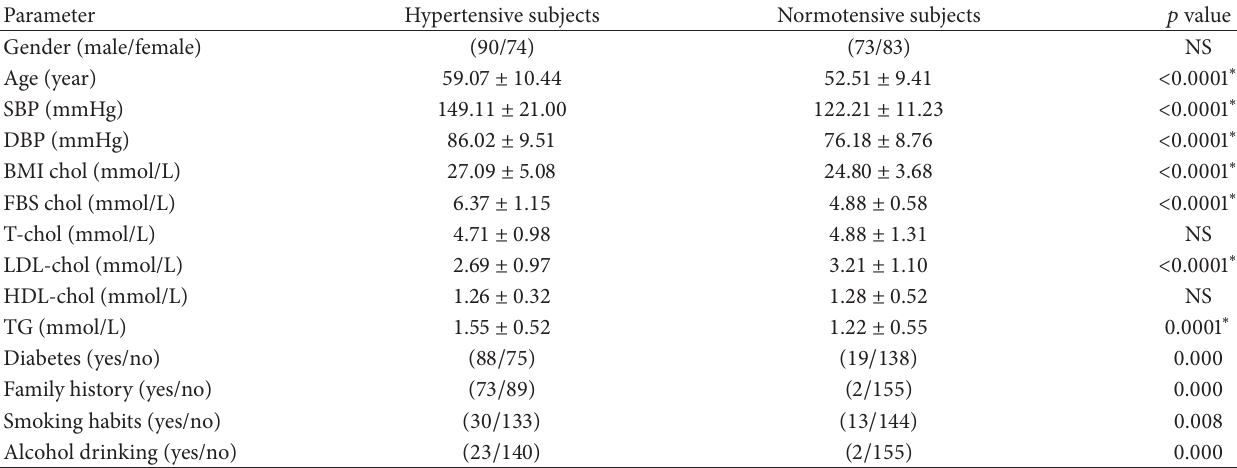
Table 1: Baseline characteristics of the subjects ± .